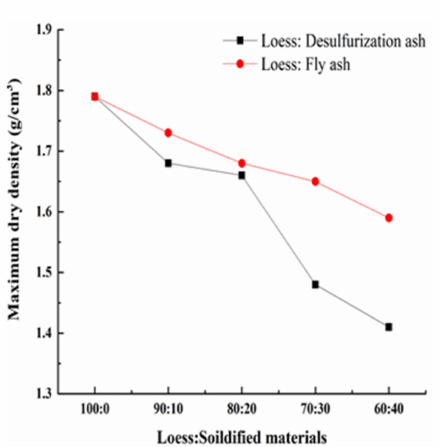
Figure 4. The relationship between maximum dry density and solidified